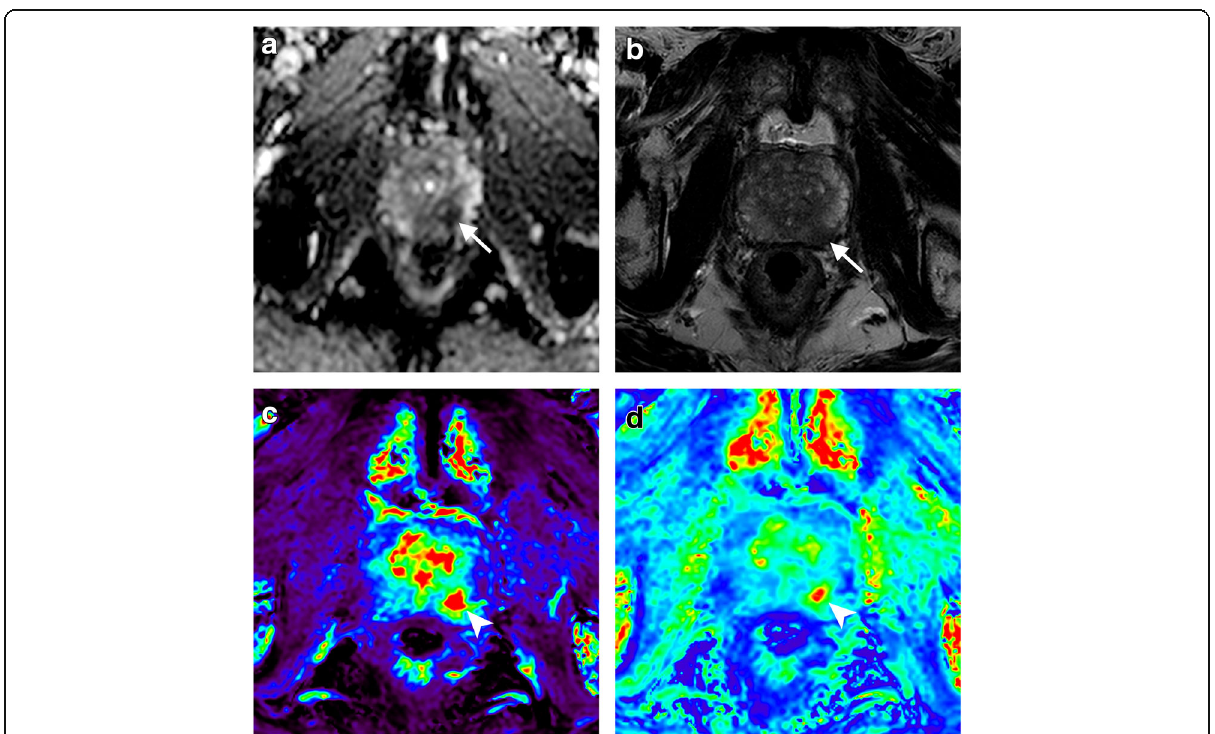
Fig. 6 Quantitative DCE imaging in a 71-year-old man undergoing pre-biopsy mpMRI for a left mid PZ cancer (Gleason score 3 + 3 on pathology after radical prostatectomy), showing restricted diffusion on the ADC map ( a ) and hypointensity on T2-weighted imaging ( b ) (arrows). DCE parametric maps obtained using the extended Tofts model showed markedly increased K trans (arrowhead in c ) and K ep (arrowhead in d ) compared to the surrounding PZ (see Table 4 for